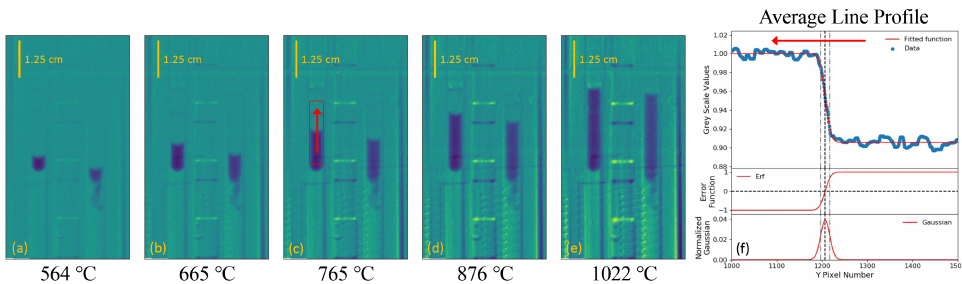
Figure 2. ( a – e ) Images of LiCl + KCl eutectic samples at varying temperatures normalized to the 463 ◦ C image with highly adjusted contrast. ( f ) A plot of the pixel grey scale value as a function of the y-pixel height, averaged over the region highlighted in red shown in ( e ). These grey scale values are fitted with a normal distribution error function (Equation (1)) to extract the centroid and standard deviation for the location of the meniscus in the given image. It should be noted here that a slight tail structure can be observed in the right-hand sample. This structure, while not directly observed in the image taken at 463 ◦ C, is highlighted with this ratio